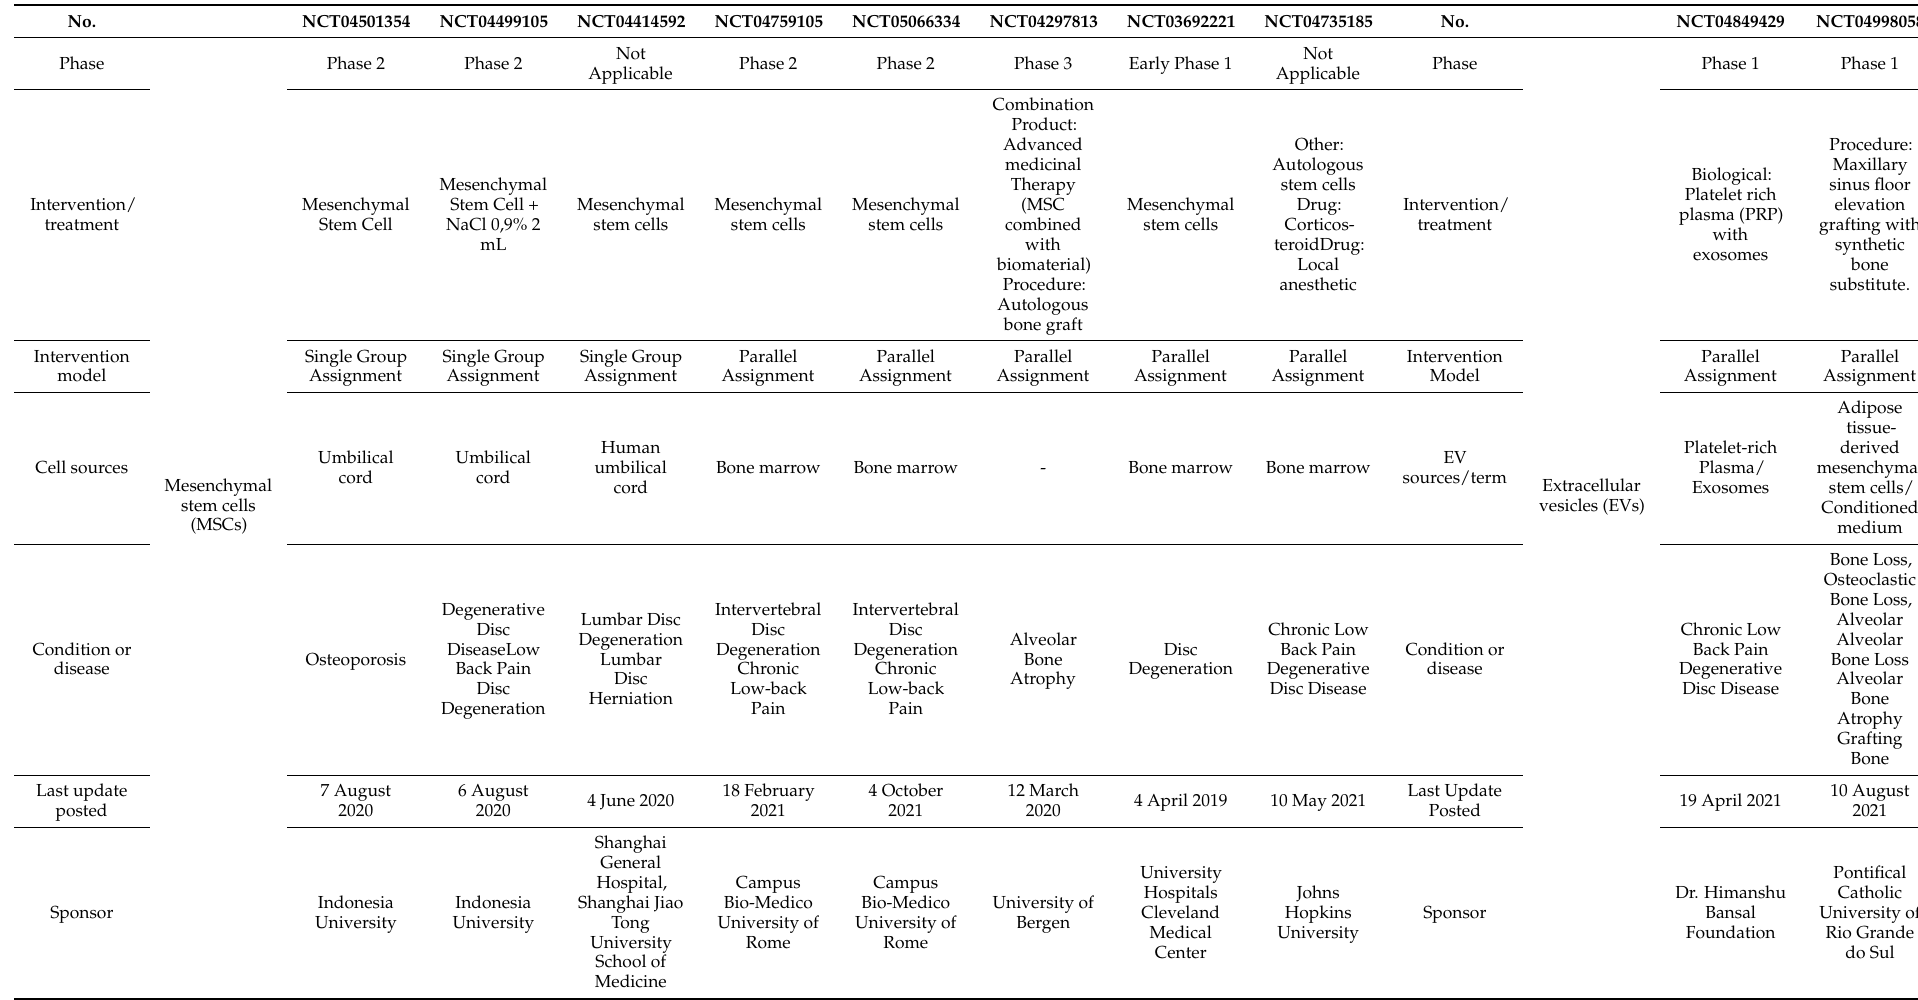
Table 1. Ongoing clinical trials of MSC and MSC-EVs therapy for bone diseases registered in Clinical Trials.gov. The data were obtained in October 2021.